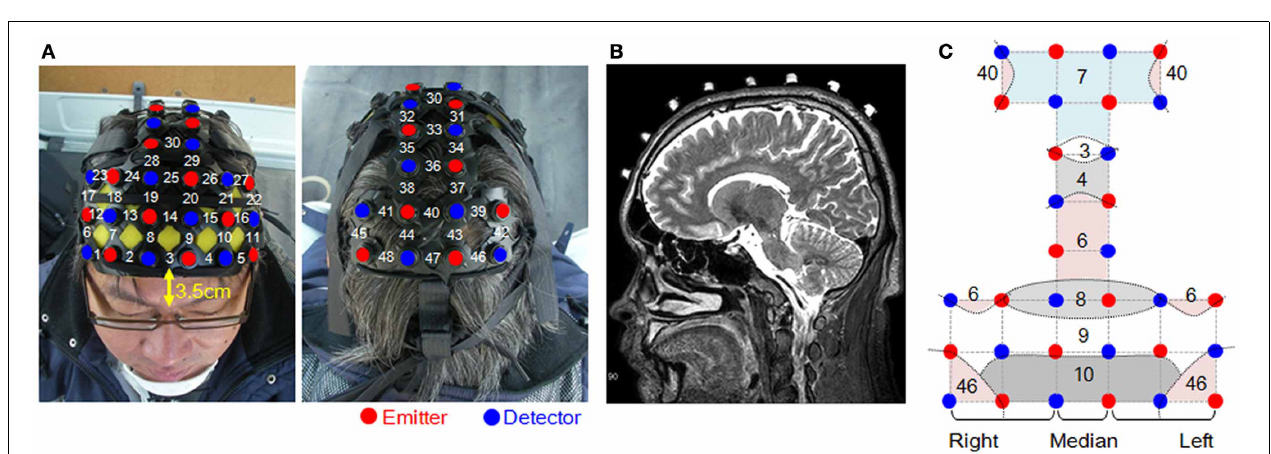
FIGURE 2 | Measurement sites and the locations of the probes. (A) Head probe attachments and channel numbers. (B) Positioning of the probes was confirmed using MRI. (C) Dashed curves represent the